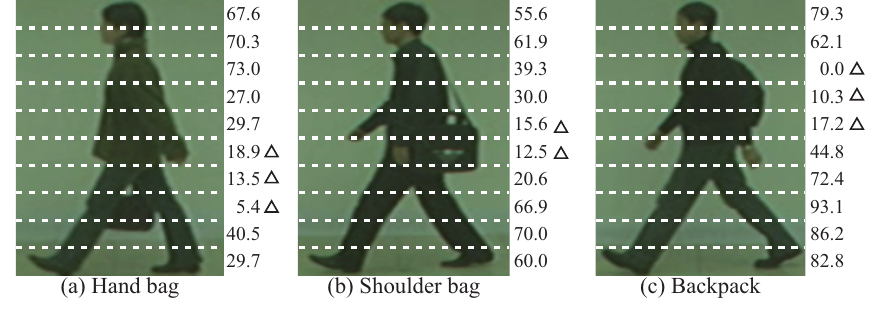
Figure 11. Rate of assigned high matching weight in each area ( K = 10 ) [ % ]. Triangles show areas with appearance changes.